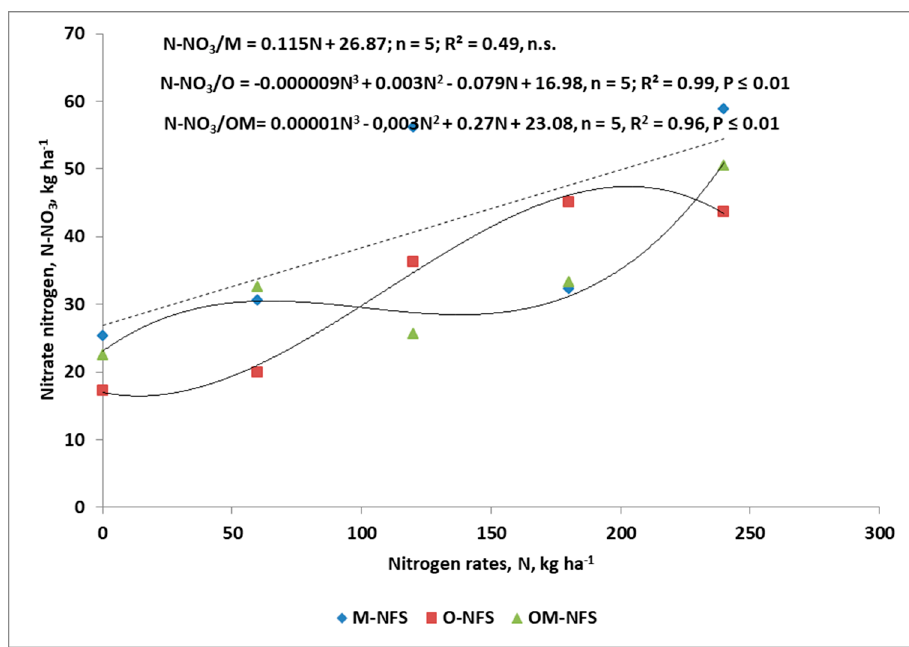
Figure 5. Trends in the N nitrate content at WOSR ripening for three nitrogen fertilization systems (NFSs). M-NFS, O-NFS, OM-NFS—mineral, organic, organic-mineral NFS, respectively.